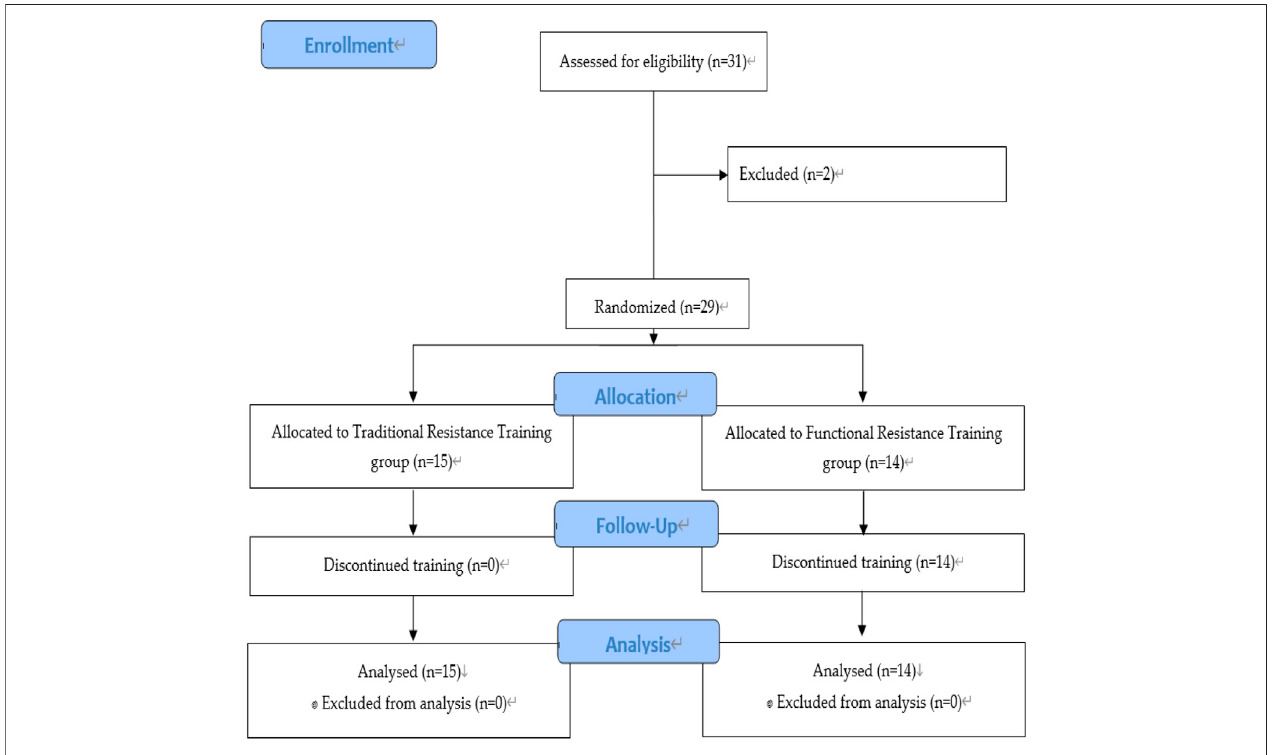
FIGURE 1 | Study Flow chart (Schulz et al.,